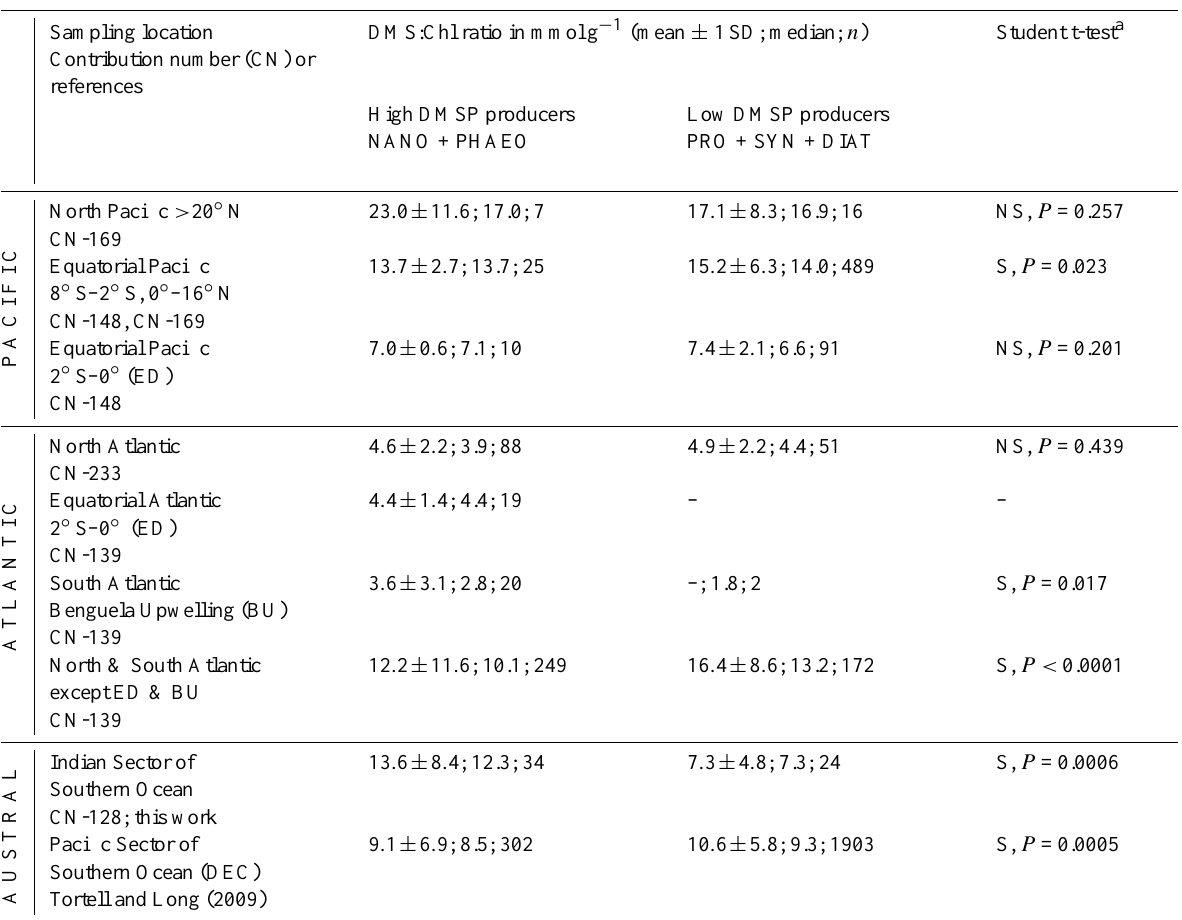
Table 3. Mean DMS:Chl ratios sorted by oceanic regions and by phytoplankton group dominance to trace the dominance of high and low DMSP